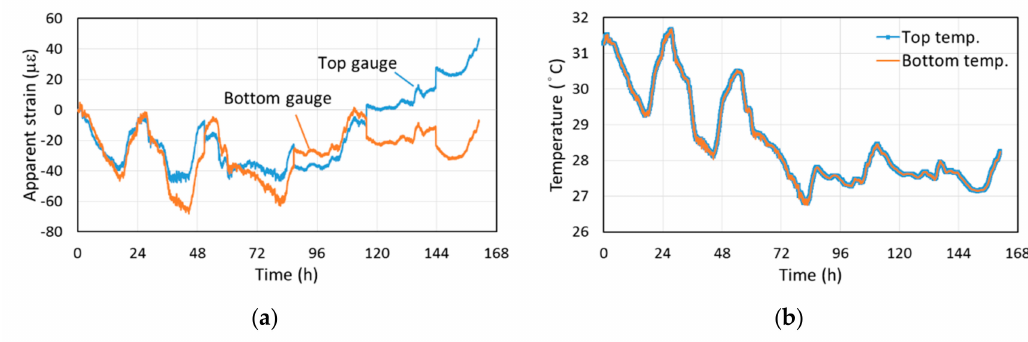
Figure 10. The concrete beam test: ( a ) strain recorded at the top and bottom of the beam midpoint; ( b ) temperature at the top and bottom of the beam